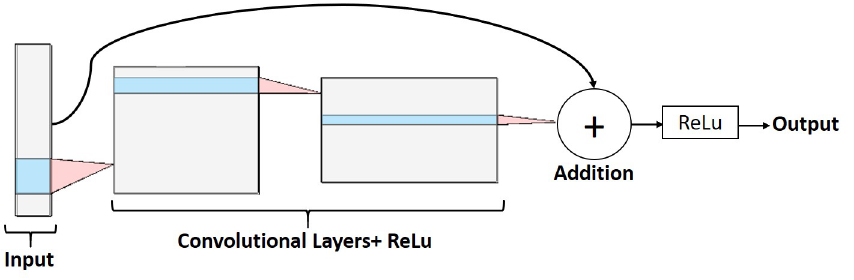
Figure 2. Example of a residual CNN architecture. The figure was generated using NN-SVG